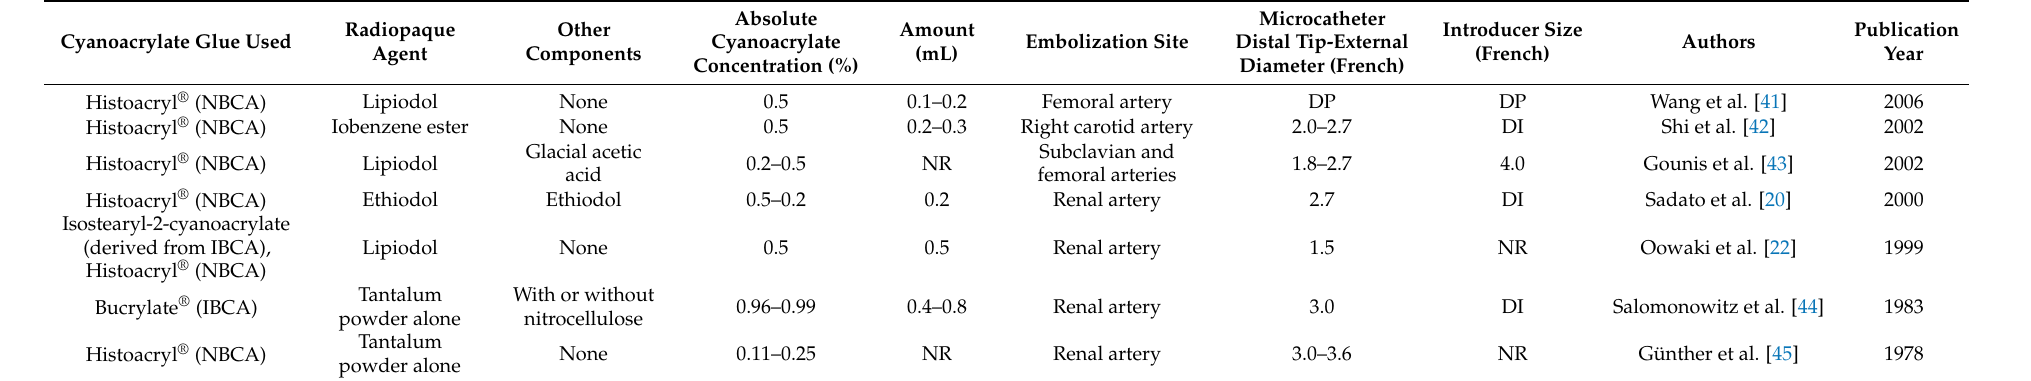
Table 3. Quantitative data from studies of rabbit